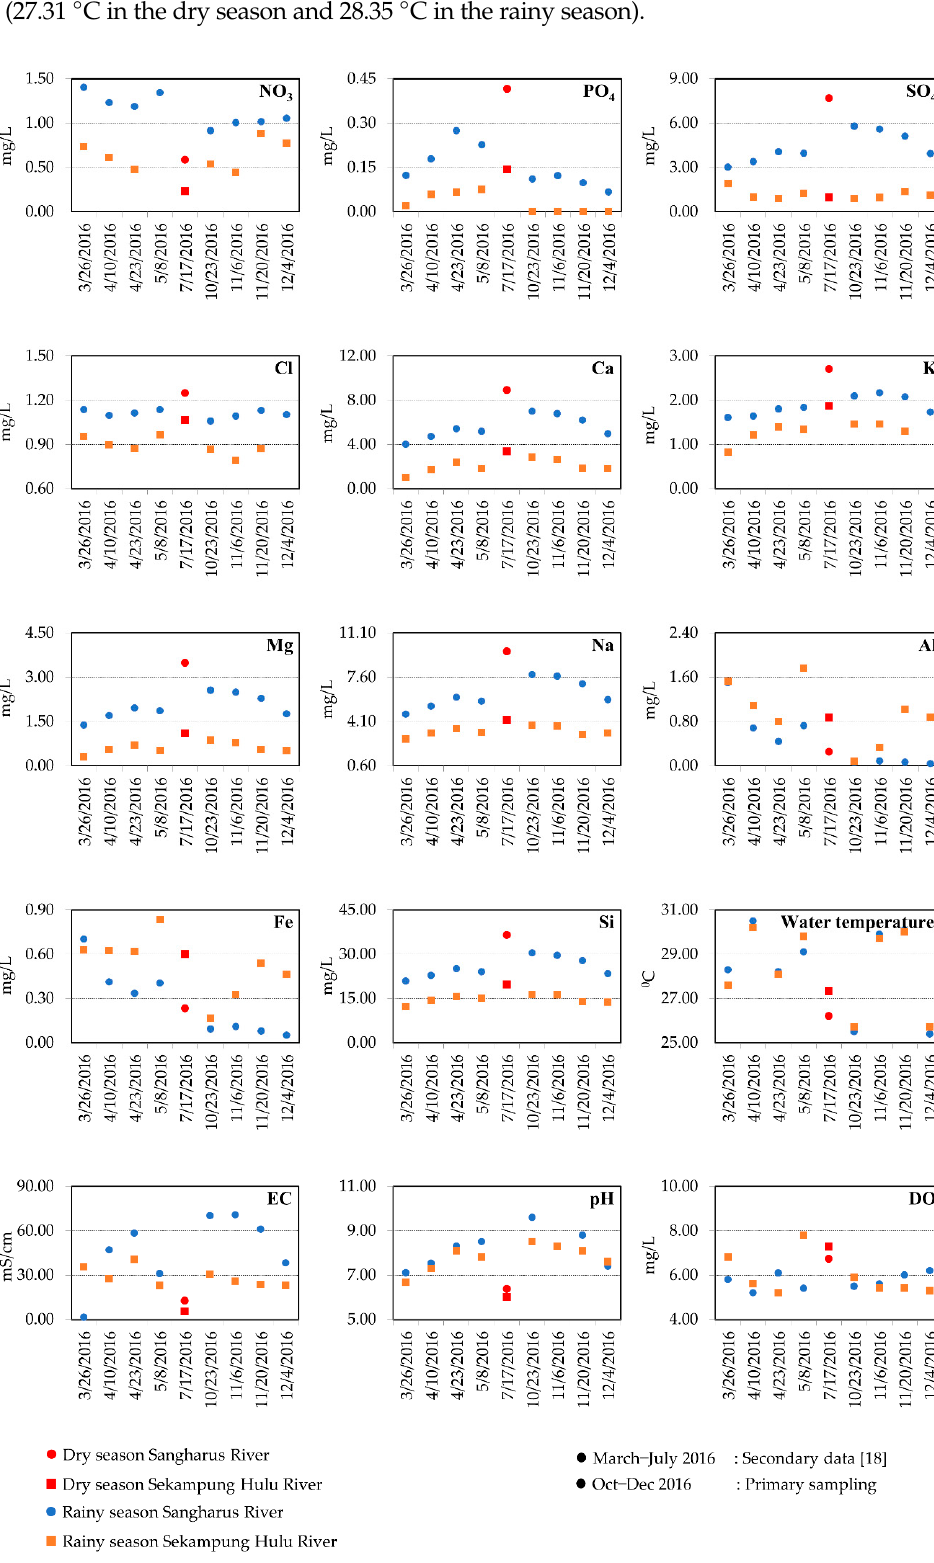
Figure 4. Water quality comparisons between the Sekampung Hulu and Sangharus Rivers.